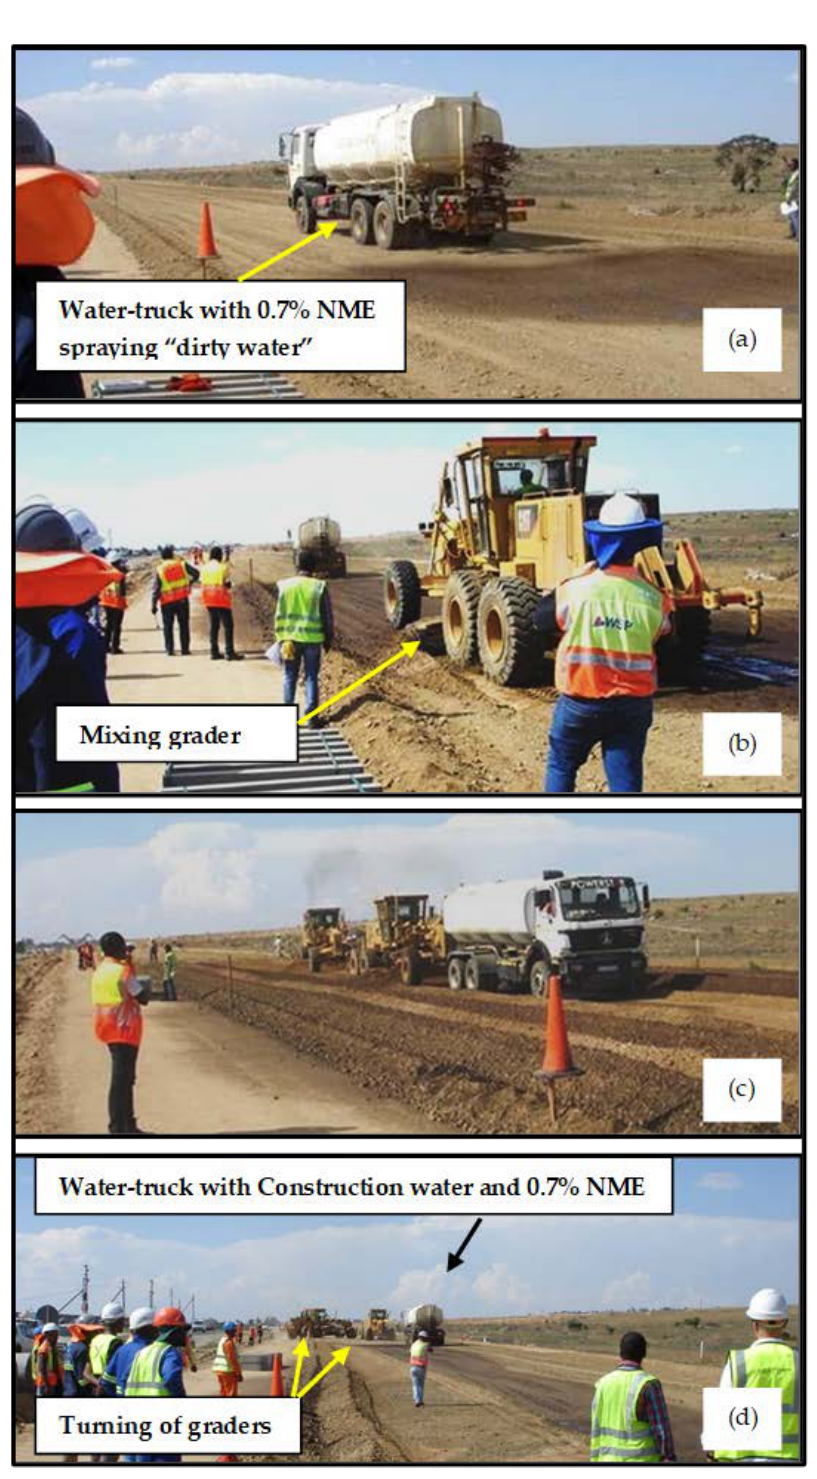
Figure 14. The granular material for the construction of the sub-base is spread along the section to be stabilised and compacted, allowing for the compaction factor. ( a ) The water-bowser containing the anionic NME pre-mixed with the required construction water is starting with the spraying of the NME mix. ( b , c ) The water-bowser is closely followed by graders that are mixing the NME stabilising agent with the construction water over the pre-determined length and width of the road. ( d ) Due to the turning movements and continued process of spraying and mixing, the construction of a section of road using conventional equipment is considerably more time consuming compared to the use of central mixing plants with paving equipment or with recycling equipment.